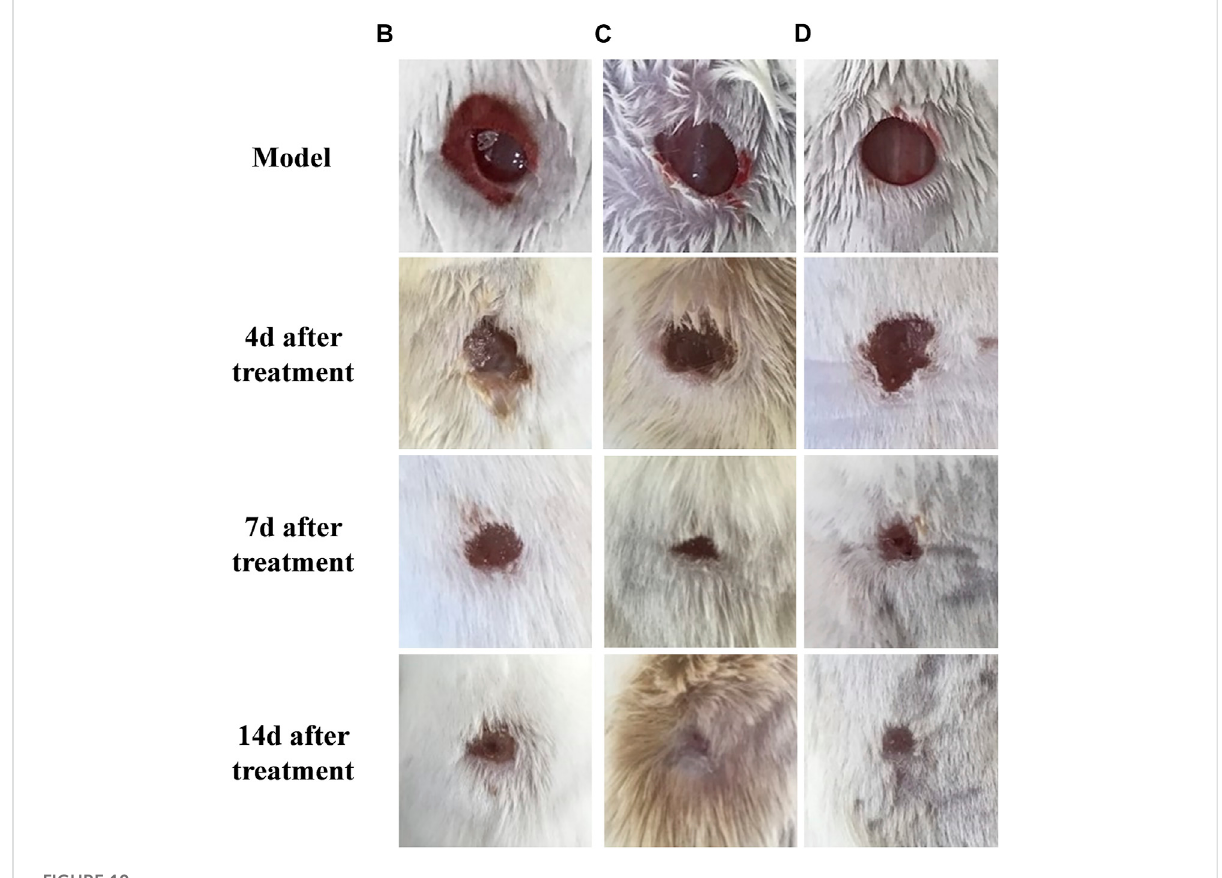
FIGURE 10 Photographs of skin wounds at 4, 7, and 14 days after